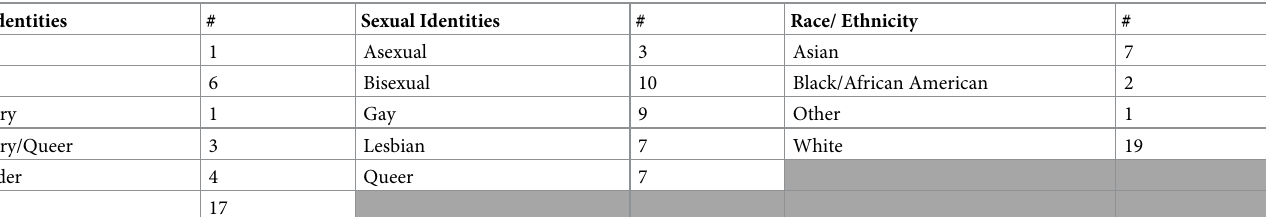
Table 1. Participant